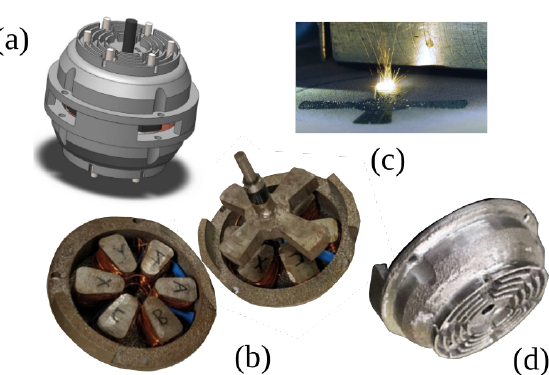
Figure 10. A model ( a ) and the geometry ( b ) of a 3D printed electrical machine. ( c ) shows one step from the design process, and ( d ) shows the printed, optimized heat